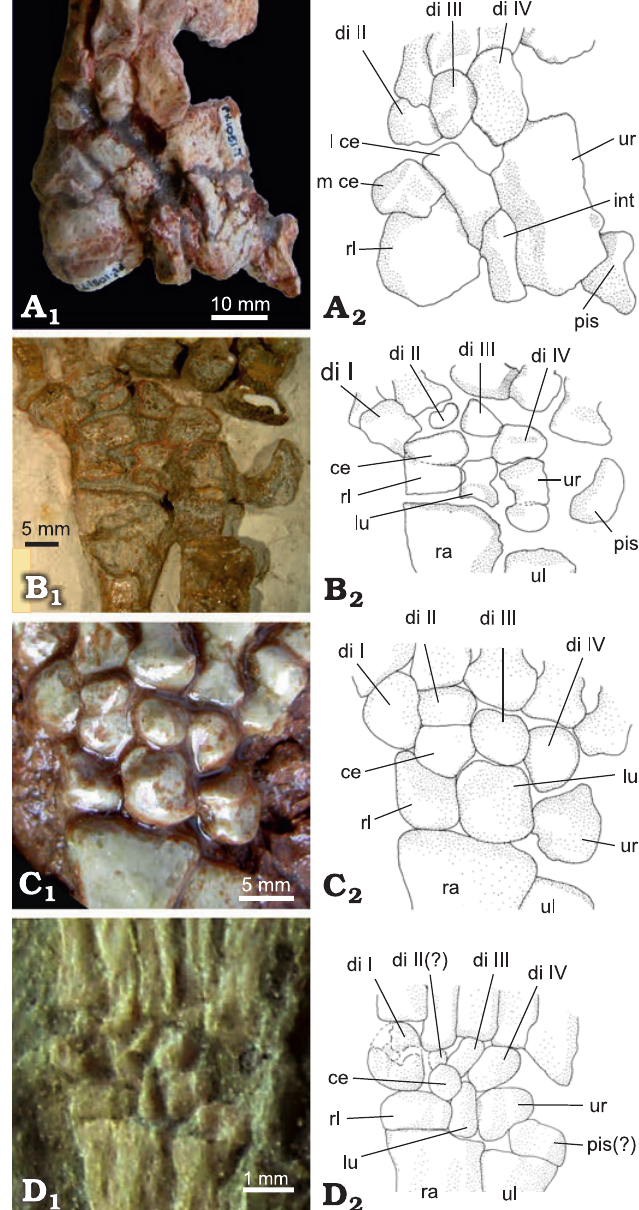
Fig. 7. Carpus of non-mammaliamorph Cynodontia. A . Procynosuchus dela harpeae Broom, 1937, RC92, Doornkloof, Graaff-Reinet, South Africa, Ciste cephalus Assemblage Zone, Lopingian, right carpus, dorsal view. B . Pro cyno suchus delaharpeae Broom 1937, NHMUK PV R 37054, Mid dle Luangwa Valley, Zambia, Daptocephalus Assemblage Zone, Changshingian, right carpus, dorsal view. C . Galesaurus planiceps Owen 1860, BP/1/2513, Honing krans, Burgersdorp, South Africa, Lystrosaurus Assemblage Zone, Early Triassic, left carpus (reversed), dorsal view. D . Cynognathia indet. BP/1/4534, Hugoskop 620, Roxville, South Africa, Cynognathus Assem- blage Zone, Olenekian–Anisian, left carpus (reversed), dorsal view. Photo- graphs (A 1 –D 1 ) and interpretative drawings (A 2 –D 2 ). Abbreviations: di, dis- tal carpal; int, intermedium; l ce, lateral centrale; m ce, medial centrale; pis, pisiform; ra, radius; rl, radiale; ul, ulna; ur, ulnare.